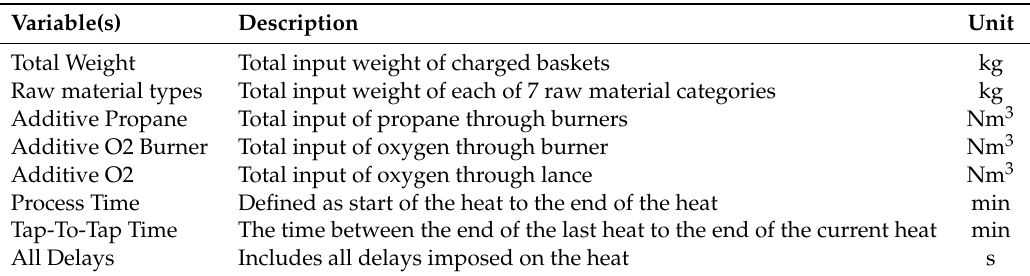
Table 2. Variables used in the final electrical energy consumption